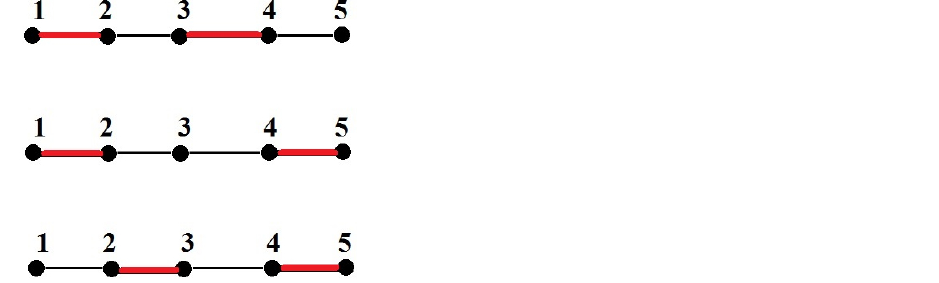
Figure 4. There are three possible packings of L 5 by pairs. According to Lemma 8, x 1 = x 3 = x 5 = 0. Moreover, x 1 + x 2 = 1, x 3 + x 4 = 1, so x 2 = x 4 = 1. There is only unique point in the core: ( 0;1;0;1;0 )